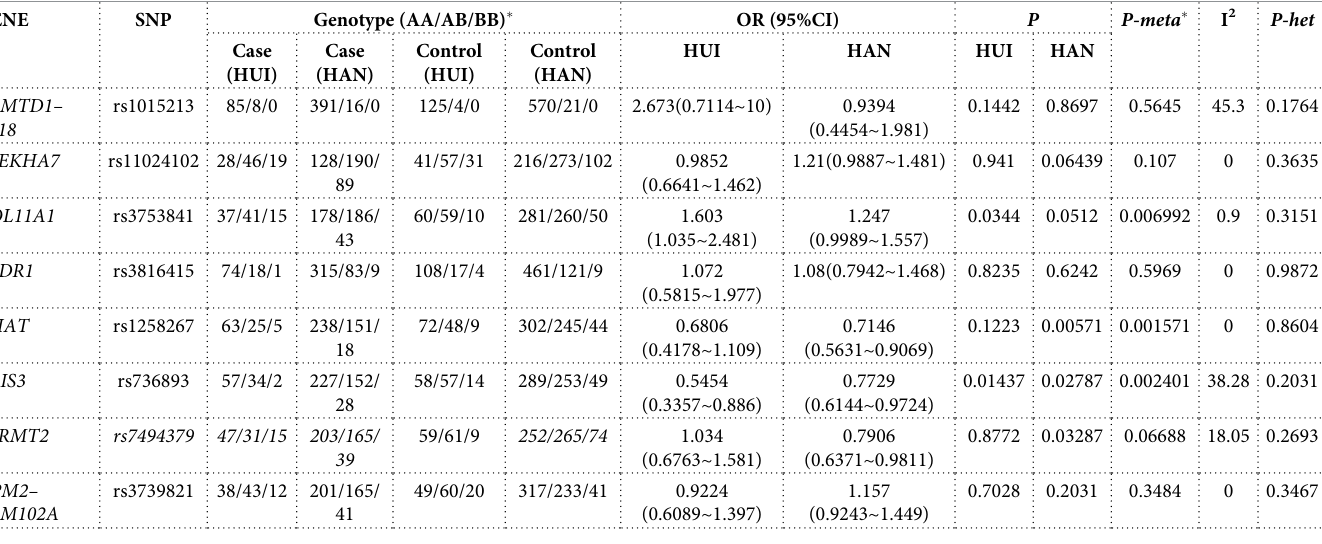
nificant association with PACG (Table 3). In the next analysis, the association between the eight SNP genotypes and AL and ACD ocular biometric parameters in the case group was evaluated using GEE tests. We found rs3753841 in COL11A1 , rs1258267 in CHAT and rs736893 in GLIS3 were nominally associated with the ACD (p = 0.023, 0.016 and 0.01, respectively). Among the three SNPs, the variant alleles may have the effect of shallowing the ACD ( β = -0.046) for rs3753841 in COL11A1 and deepening the ACD for rs1258267 in CHAT and rs736893 in GLIS3 ( β = 0.054 and 0.058, respectively) (Table 4). Nevertheless, none of the SNPs surpassed FDR correction for multiple testing in GEE analysis.